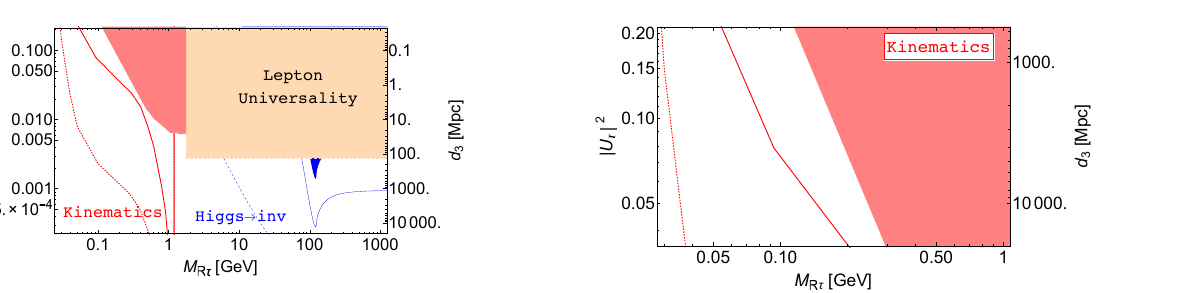
Figure 5. Same as Fig. 4 except for ˜ y τ = M ψ = τ (cid:31)